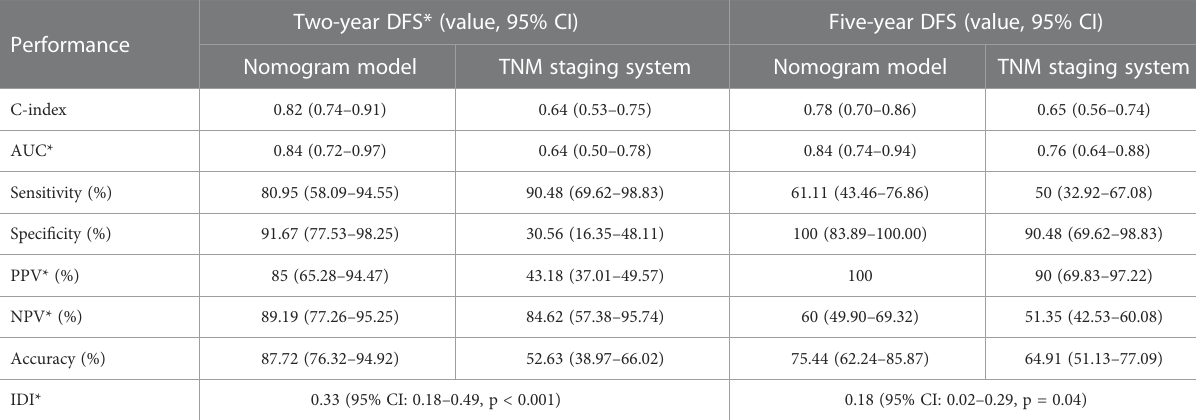
TABLE 3 Comparison of performance between nomogram model and the TNM staging system in predicting DFS of ESCC patients.